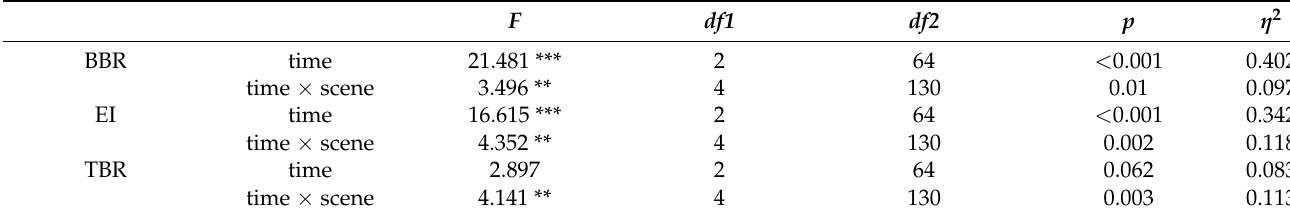
Table A8. Results of multivariate test of calculation indicators.